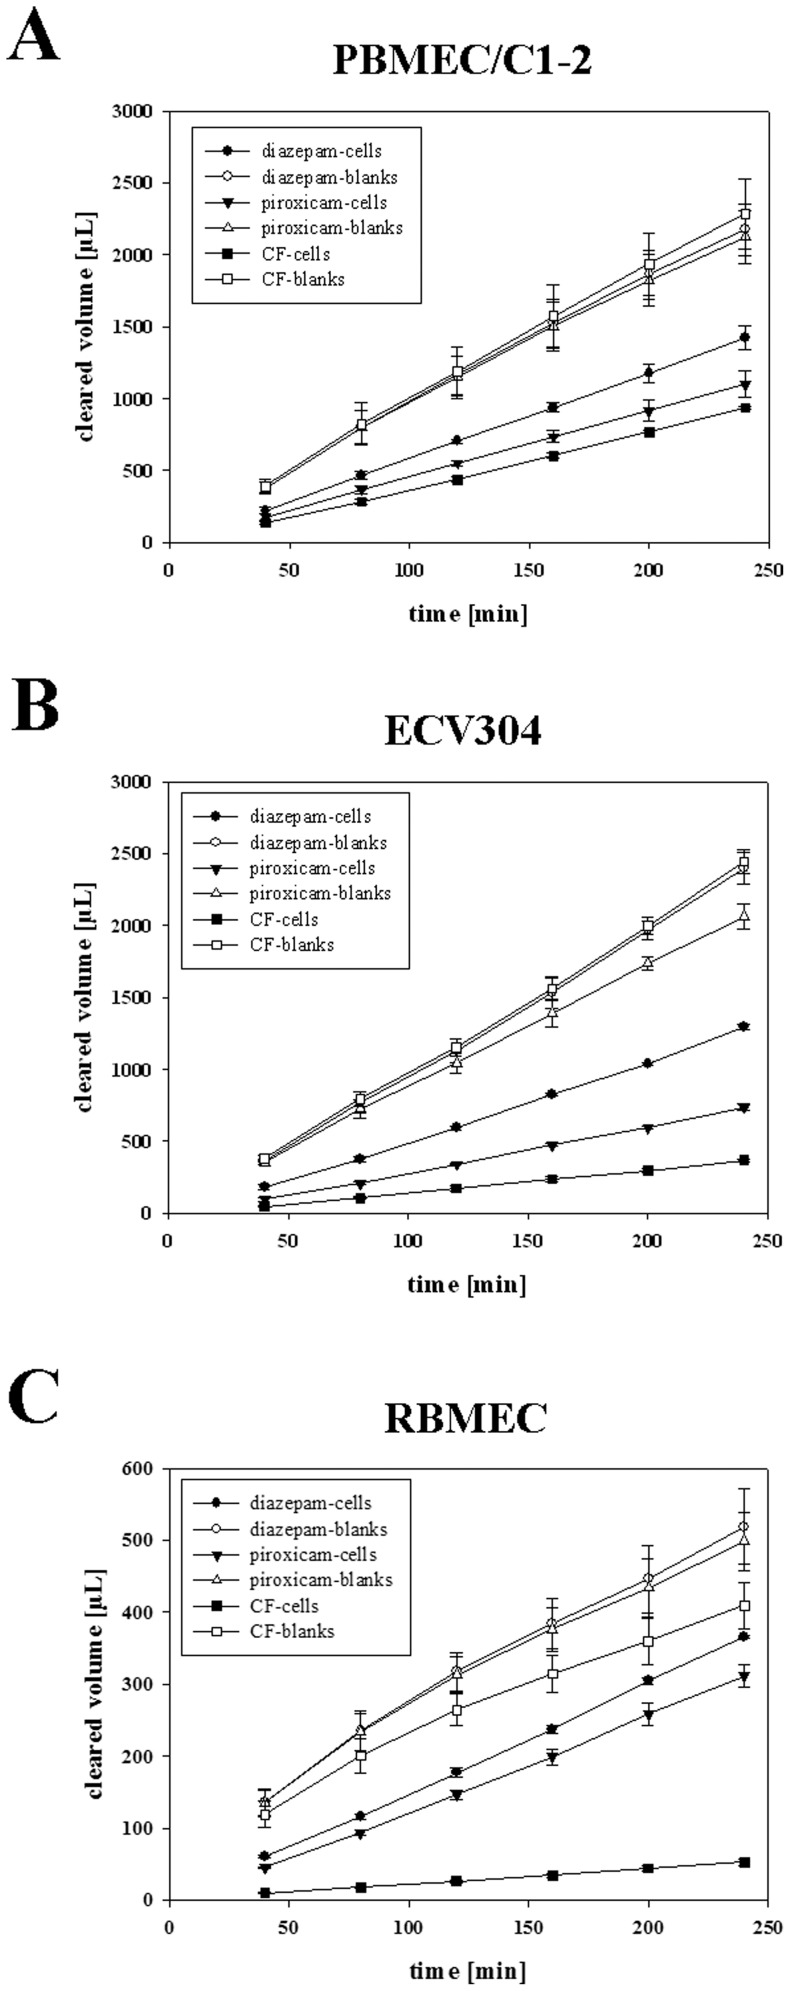
Time courses of single transport studies of piroxicam across PBMEC/C1-2, ECV304 and RBMEC layers.Comparison between the cleared volume vs. time graphs of internal standards for the transcellular transport route (diazepam, 100 µM), the paracellular transport route (carboxyfluorescein, 5 µM) and the NSAID piroxicam (100 µM) showed clearly that piroxicam permeated between the two markers across all three BBB (A: PBMEC/C1-2; B: ECV304; C: RBMEC) in vitro models. In addition, it was proved that as tighter the model is a wider frame between the two markers diazepam and carboxyfluorescein could be provided to analyze and compare permeabilities of single drugs. (n = 3 for each time point, data are presented as means ± SD).